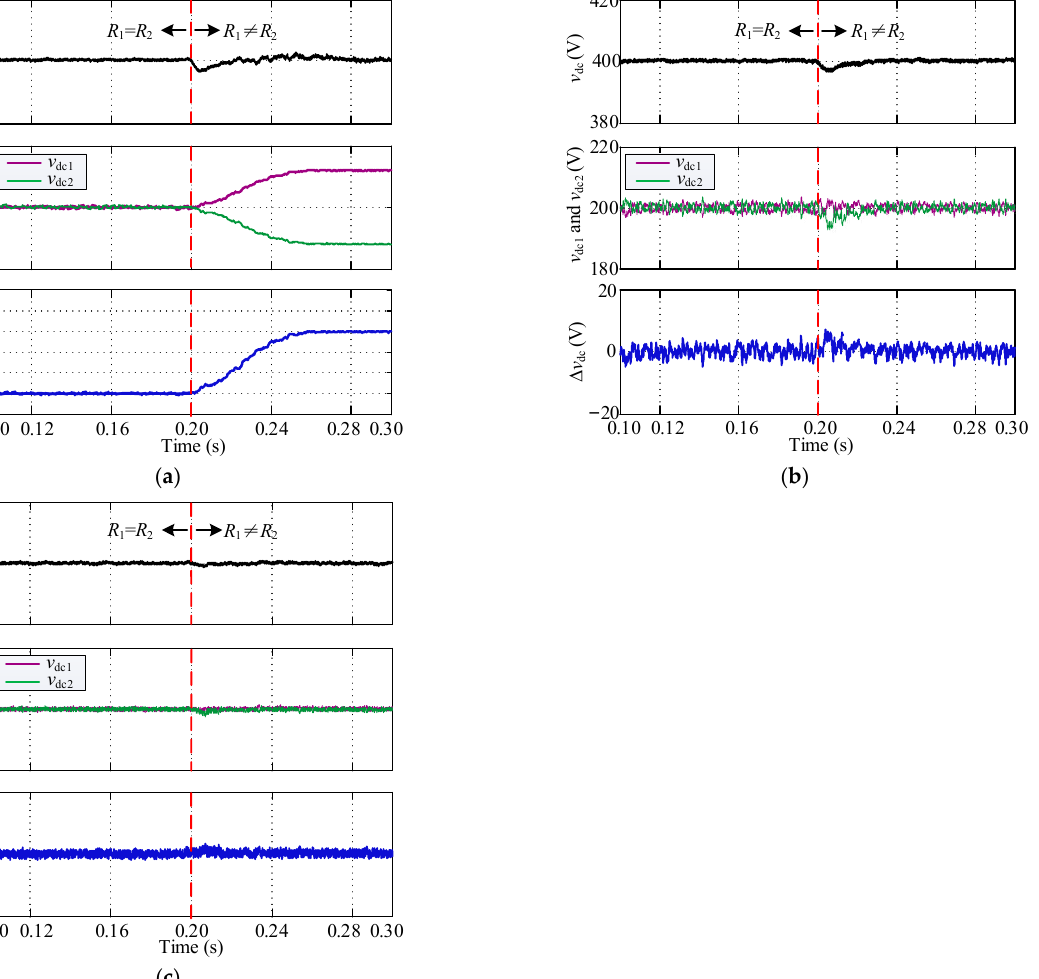
Figure 5. Performance comparison of the methods when the loads jump from equal to unequal. ( a ) No NPV control strategy is adopted; ( b ) ZSV-J; ( c ) the proposed NPV control method.